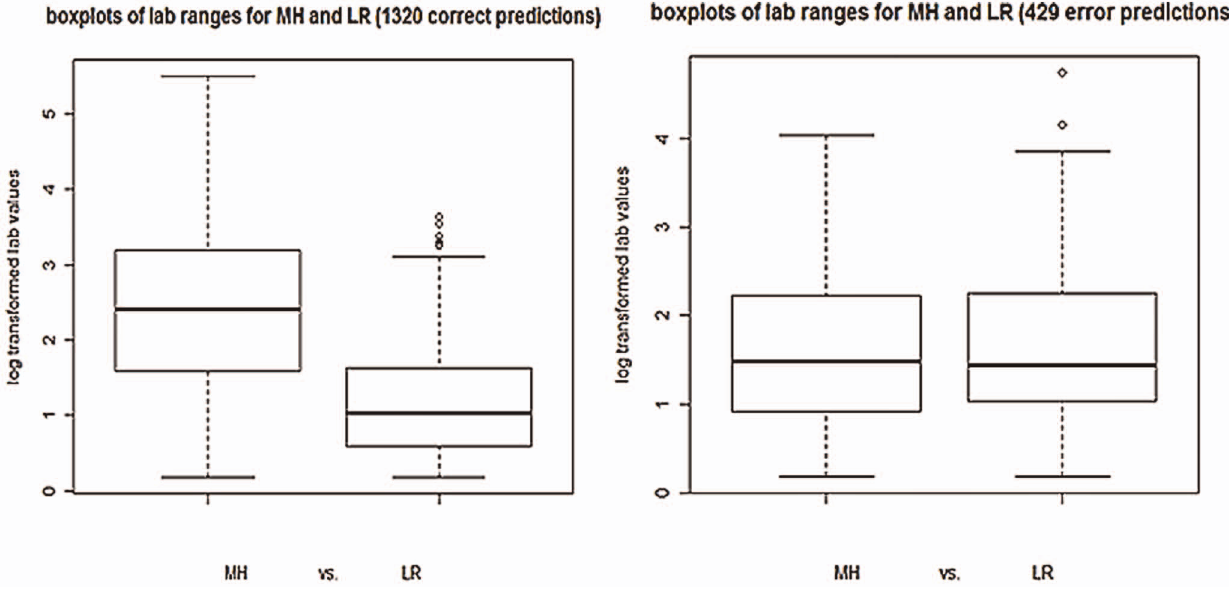
Figure 6. Ranges of lab values. (Left) Range of lab values for Moderate/High (MH) disease activity cases vs. Range of lab values for Low/Remission (LR) disease activity cases among 1320 correctly classified notes. (Right) Range of lab values for Moderate/High (MH) disease activity cases vs. Range of lab values for Low/Remission (LR) disease activity cases among 429 misclassified notes.